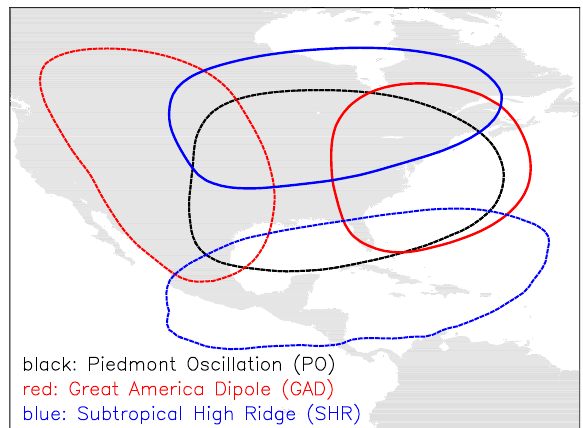
Fig. 6 A sketch diagram showing the main action centers of these three NASV modes. Solid lines represent high-pressure centers and the dashed lines denote low-pressure